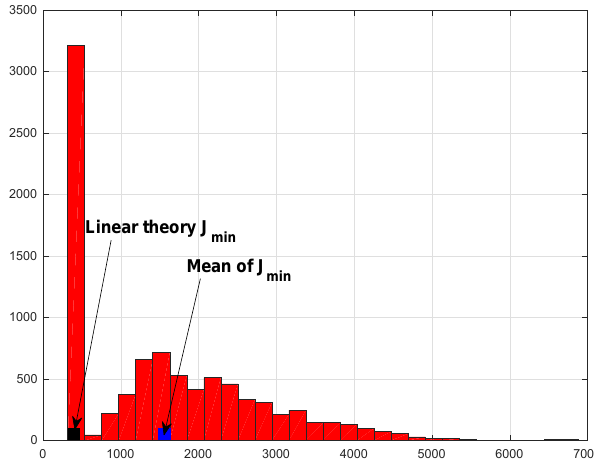
Figure 2. Histogram of (half) the values of the minima of the ob- jective function (I-9), for the same experiment as in Fig.